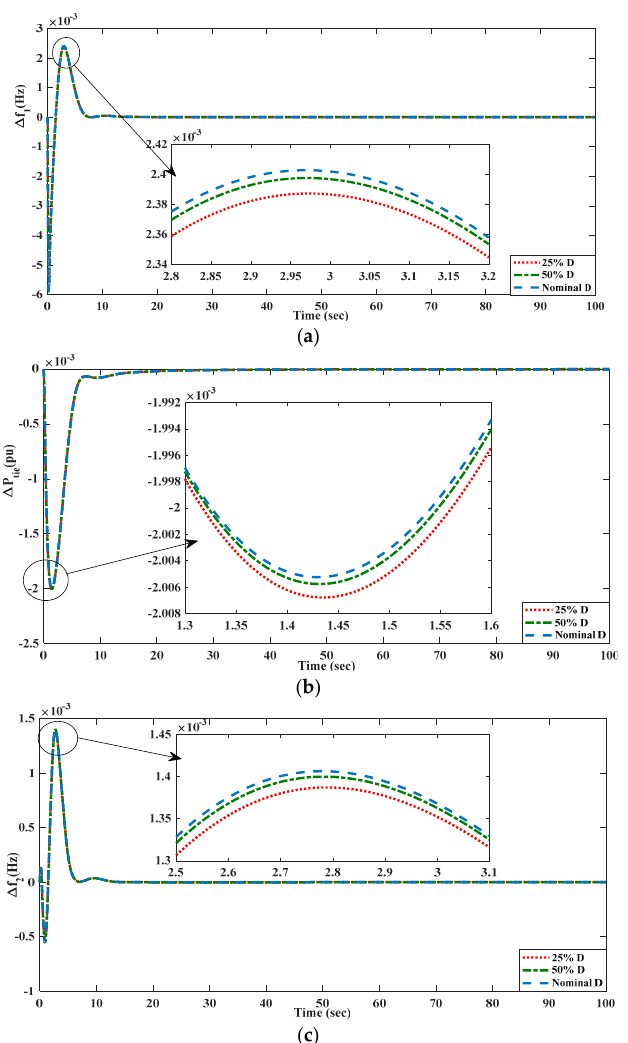
Table 20. TID parameters for the combined AGC and AVR system with RLD, all non-linearities, and a 0.2 s delay. Parameter